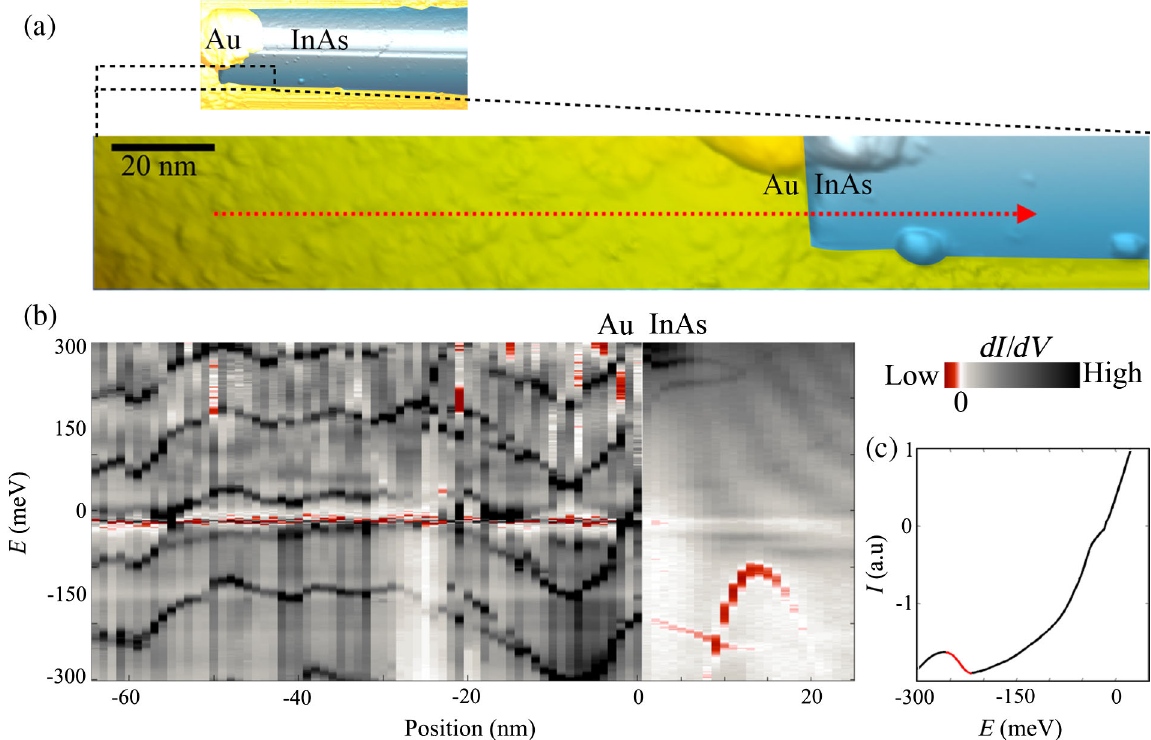
FIG. 7. (a) Topographic images of the interface between an InAs nanowire and the gold catalyst. The disordered surface of the gold particle may indicate the granularity or polycrystalline structure that gives rise to quantization. (b) dI=dV map along the red dashed arrow in (a). The spectrum on the gold particle has distinct resonances, with charge disorder that induces fluctuations in the energy of the resonances. The resonances leak into the nanowire where they coexist with the 1D quasiparticle interference pattern. Within the semiconducting gap ( E < − 75 meV) the resonances feature negative differential conductance, saturated to red in the false-color scale. (c) The integrated current at a position featuring negative differential conductance resonance, where the current is carried by the 1D modes of the nanowire. The red part illustrates decreasing (negative) current when increasing (negative) bias voltage, indicting current blockage of these